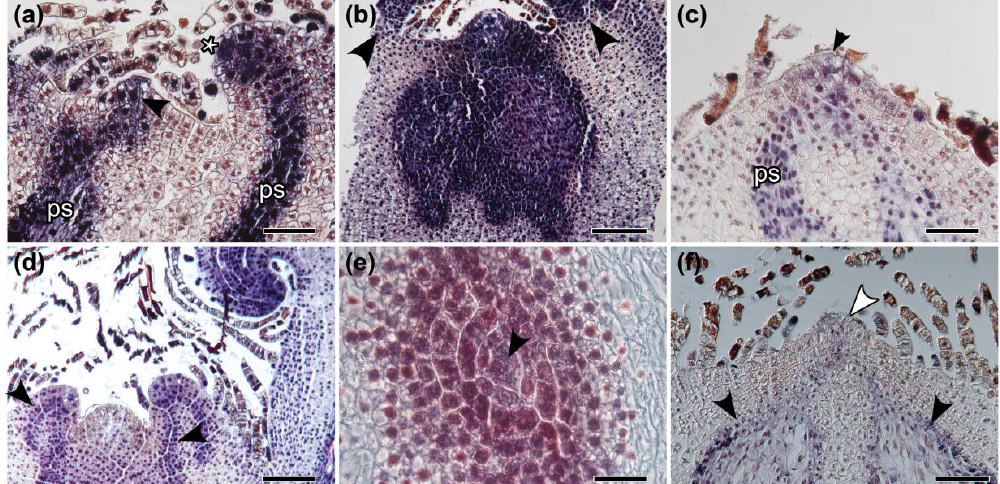
Figure 2. In situ hybridization of Class I KNOX genes and MsH4 in shoot apices of terrestrial (Tf) and climbing (Cf) forms of Mickelia scandens . ( a ) Longitudinal section of Tf. Expression of MsC1KNOX1 in the shoot apical cell (arrowhead), leaf apical cell (*), derivative cells, and procambial strands (ps). ( b ) Cf, longitudinal section. MsC1KNOX1 expression in a peripheral zone and procambium. Leaf primordia position pointed out by arrowheads. ( c ) Longitudinal section of Tf. MsC1KNOX2 expression in the shoot apical cell (arrowhead), derivative cells, and procambial strands (ps). ( d ) Longitudinal section of Cf. In this apex, MsC1KNOX2 expression is not detected in the shoot apical cell. There are procambial strands (arrowheads) connecting the SAM and the leaf primordia. ( e ) Transverse section of Tf. MsC1KNOX2 expression in a large apical cell (arrowhead) and in the surrounding derivative cells. ( f ) Longitudinal section of Cf. Scattered MsH4 expression in the SAM (white arrowhead) and in the developing vascular system (black arrowheads). Bars: ( a ) 100, ( b ) 200, ( c ) 75, ( d ) 200, ( e ) 50, ( f ) 125 µm.